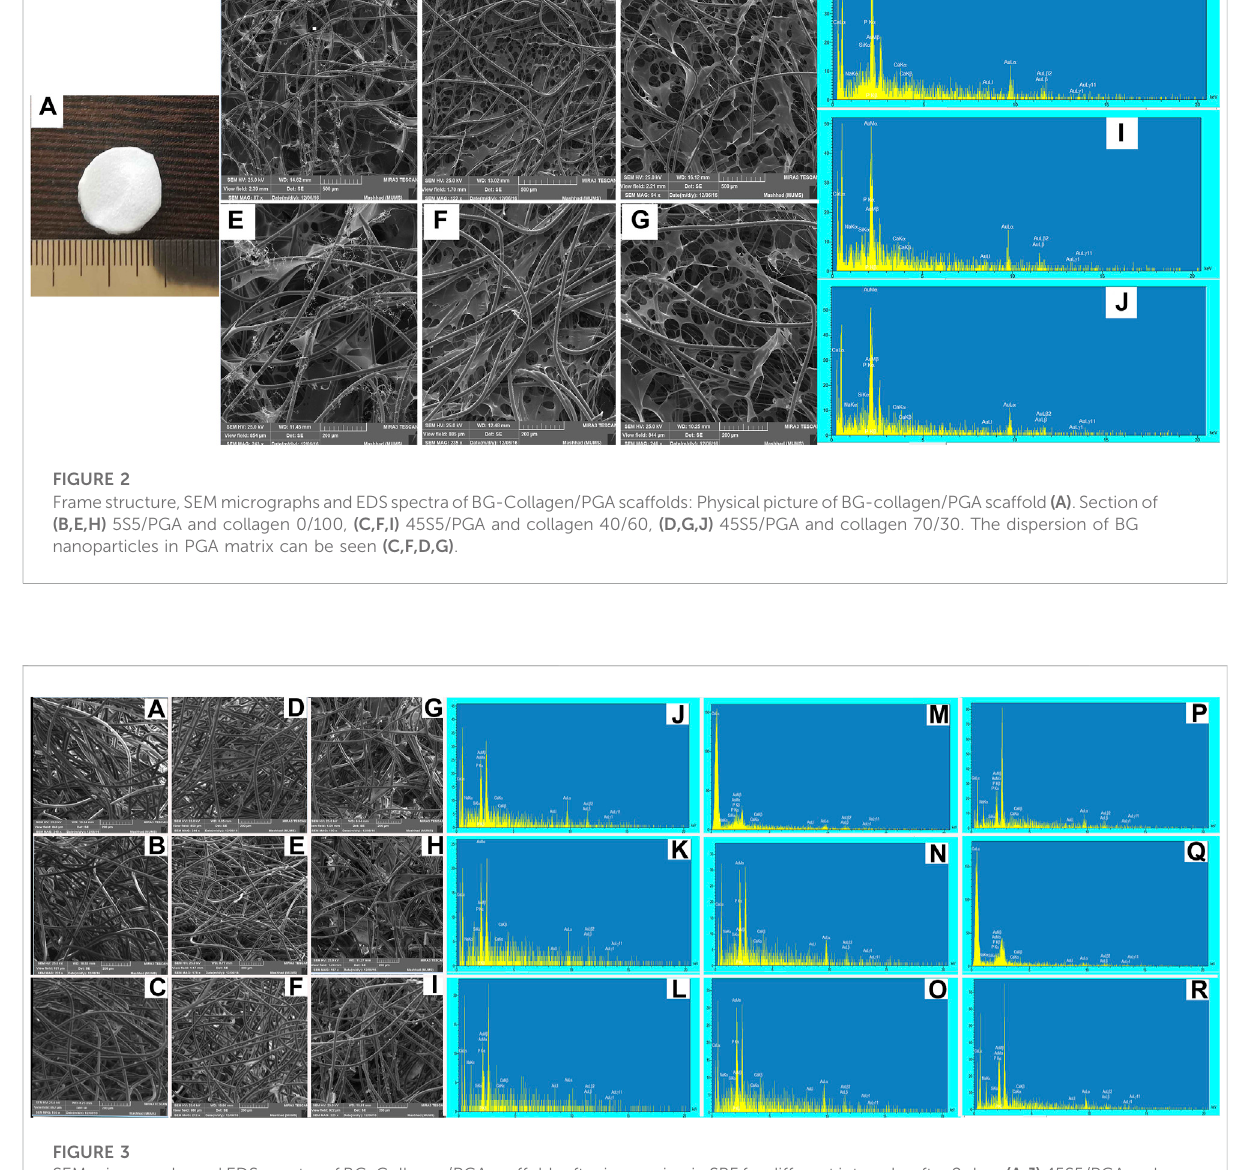
FIGURE 3 SEM micrographs and EDS spectra ofBG-Collagen/PGAscaffoldsafter immersioninSBF fordifferentintervals: after 2 days (A,J) 45S5/PGAand collagen 0/100, (B,K) 45S5/PGA and collagen 40/60, (C,L) 45S5/PGA and collagen 70/30, after 7 days (D,M) 45S5/PGA and collagen 0/100, (E,N) 45S5/PGA and collagen 40/60, (F,O) 45S5/PGA and collagen 70/30, and after 14 days (G,P) 45S5/PGA and collagen 0/100, (H,Q) 45S5/PGA and collagen 40/60, (I,R) 45S5/PGA and collagen 70/30 Figure 4. Stress – strain curves: The porous composite scaffolds compressed at a strain of (0% – 70%). The cross-head speed was 0.01 mm.s − 1